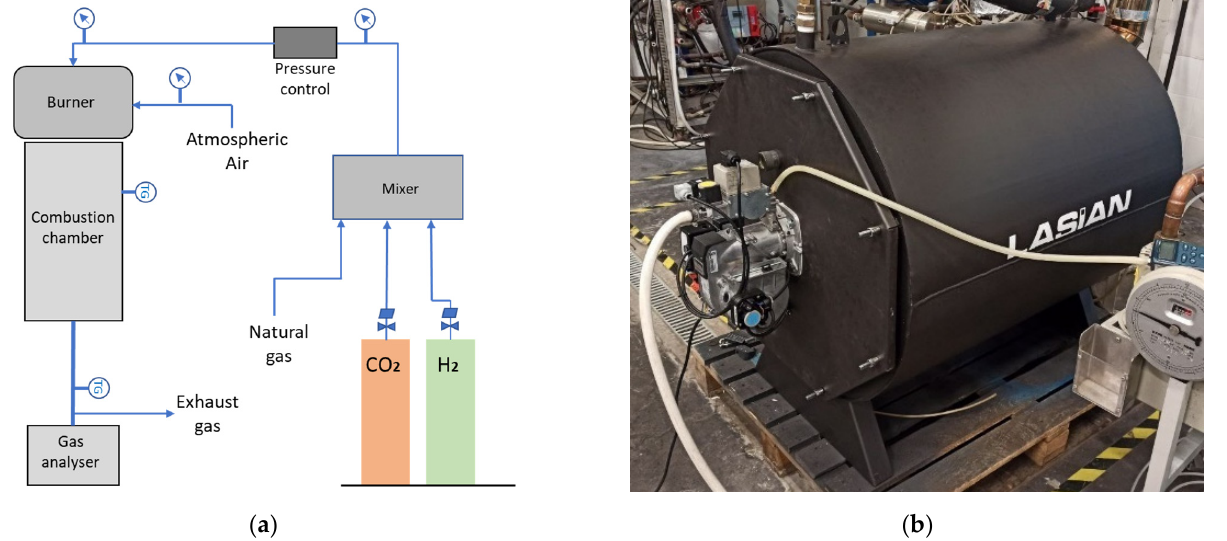
Figure 2. Combustion system setup: ( a ) setup outline; ( b ) burner and combustion chamber tested.